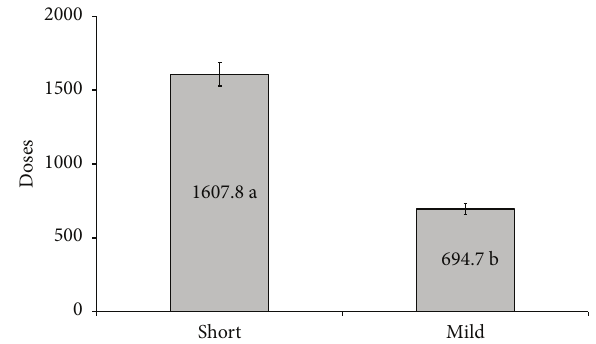
Figure 3: Doses of gonadotropins. Means followed by different letters differ significantly through the 𝑡 -test at a 5%